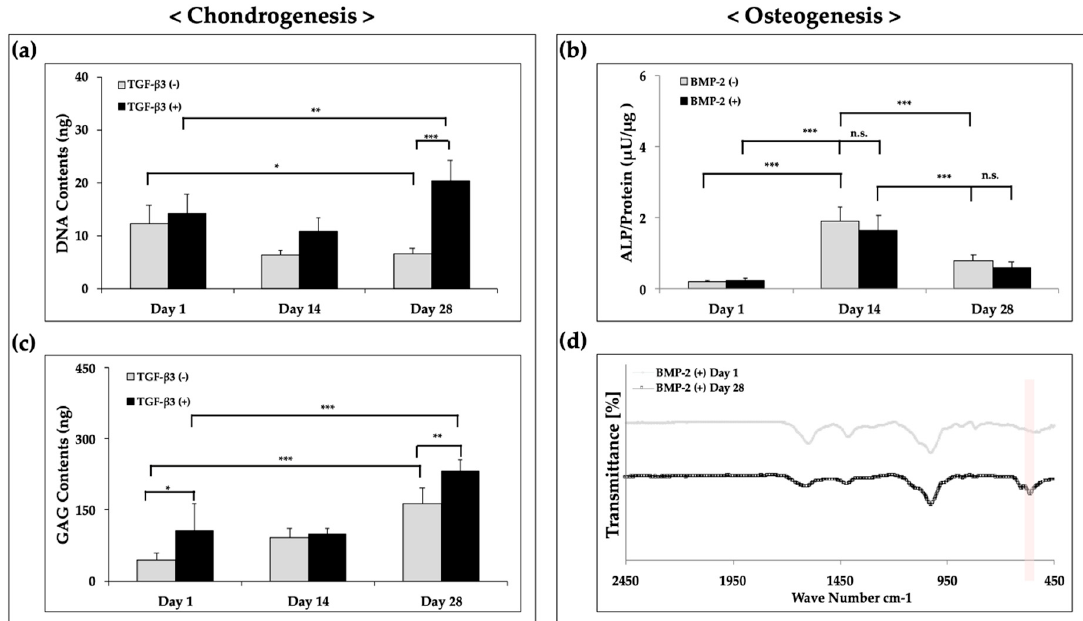
Figure 9. Biochemical and FT-IR measurements results for ( a ) DNA contents, ( b ) ALP activity, ( c ) GAG contents, and ( d ) FT-IR. * p < 0.05, ** p < 0.01, and *** p < 0.001, two-way ANOVA with Tukey’s multiple comparison test in ( a ) and ( b ), two-way ANOVA with Sidak’s multiple comparison test in ( c ).